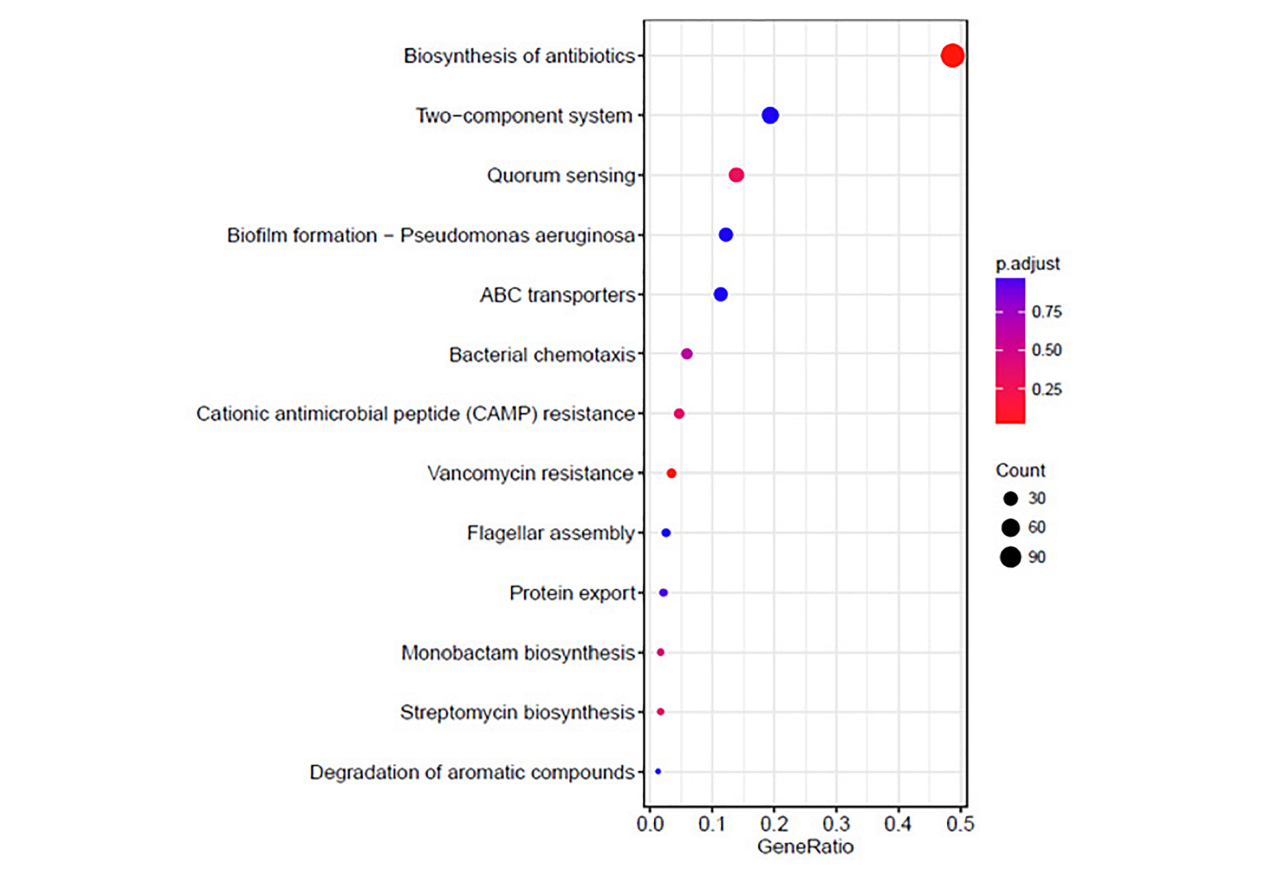
FIGURE 6 | Significantly enriched KEGG pathway scatter plot (0.00 < q -value < 1.00) of differentially expressed genes based on proteome sequencing analysis of the DADS-treated group compared to the control